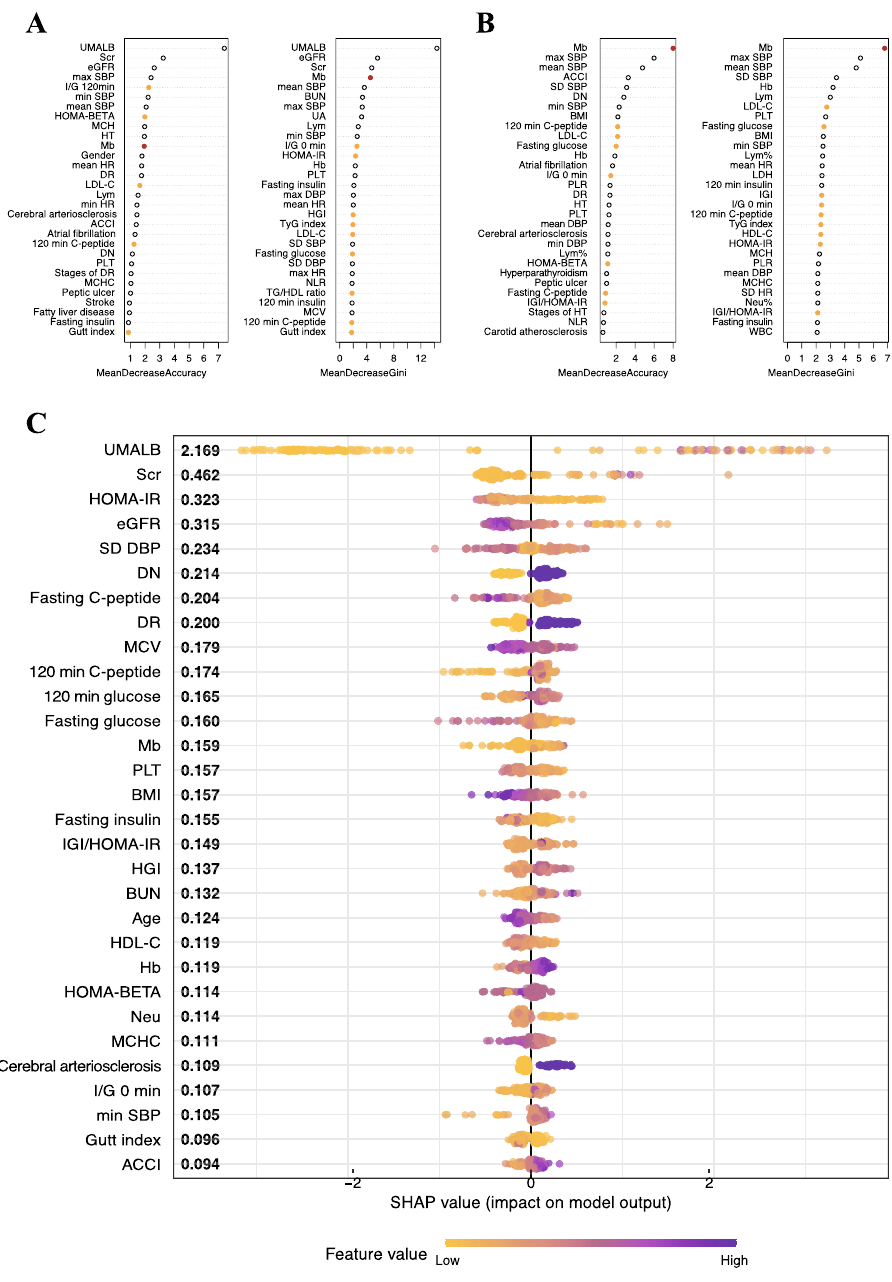
Figure 3. Feature importance analysis and model interpretation results. ( A,B ) Feature importance was estimated by mean decrease accuracy (left) and mean decreased Gini index (right) based on RF-88 and RF-83, respectively. Serum Mb and metabolic syndrome (MetS) components are indicated by red and orange dots, respectively. ( C ) Global and local importance for top 30 important features detecting by SHapley Additive exPlanation